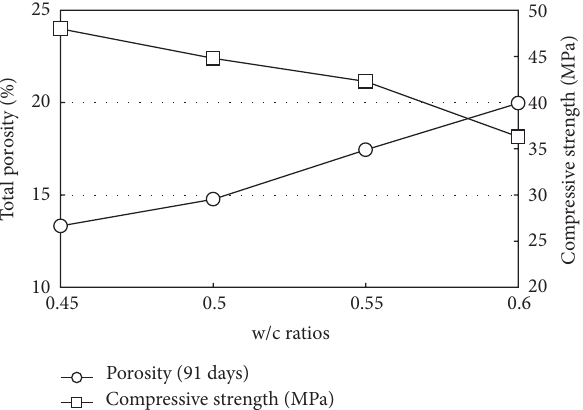
Figure 3: Strength and porosity with different W/C ratios.